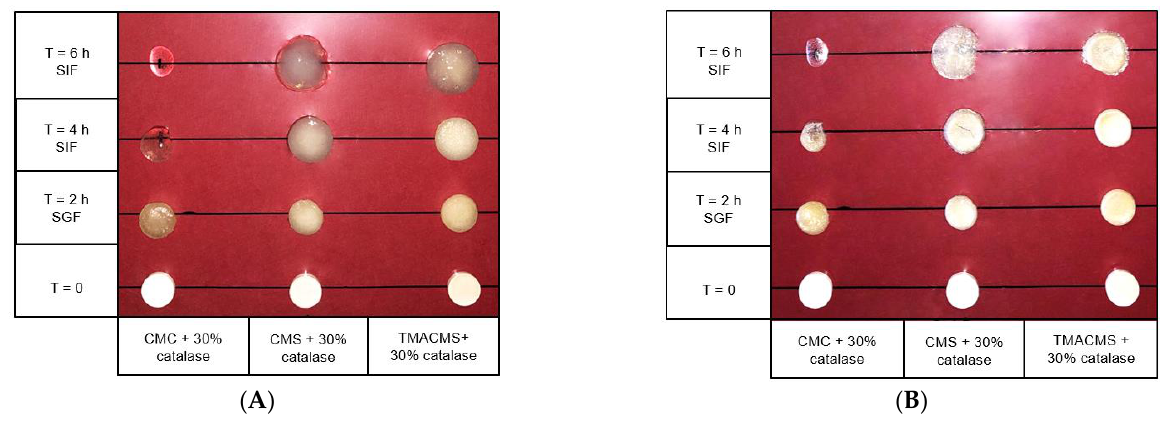
Figure 6. Pictures of the CMC, CMS, and TMACMS tablets containing 30% catalase at T = 0 (dry) and T = 2 h in SGF, followed by T = 4 and 6 h in SIF. Pictures were taken on wet ( A ) and on same tablets dried 48 h at 50 °C ( B ).